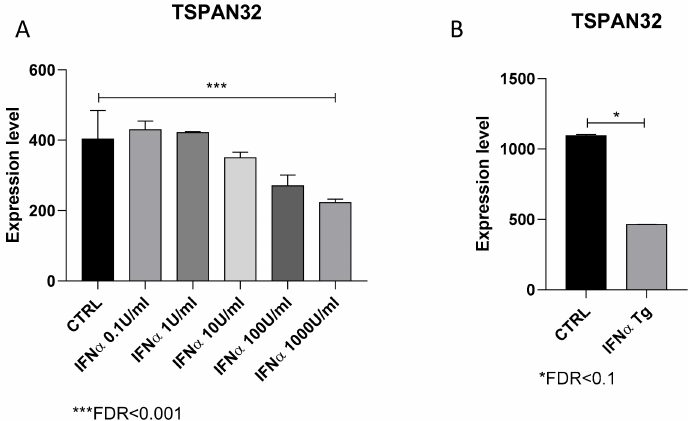
Figure 4. IFN- α downregulates TSPAN32 expression. ( A ) Expression levels of TSPAN32 in CD19 + B cells isolated from splenocytes of 6-week-old male C57BL/6mice, treated with 5 10-scalar concentra- tions of IFN- α (range 0.1–1000 U/mL) for 2 h, as determined from the GSE75194 dataset. ( B ) The levels of TSPAN32 were evaluated in splenocytes from IFN- α transgenic mice, as obtained from the analysis of the publicly available GSE123549